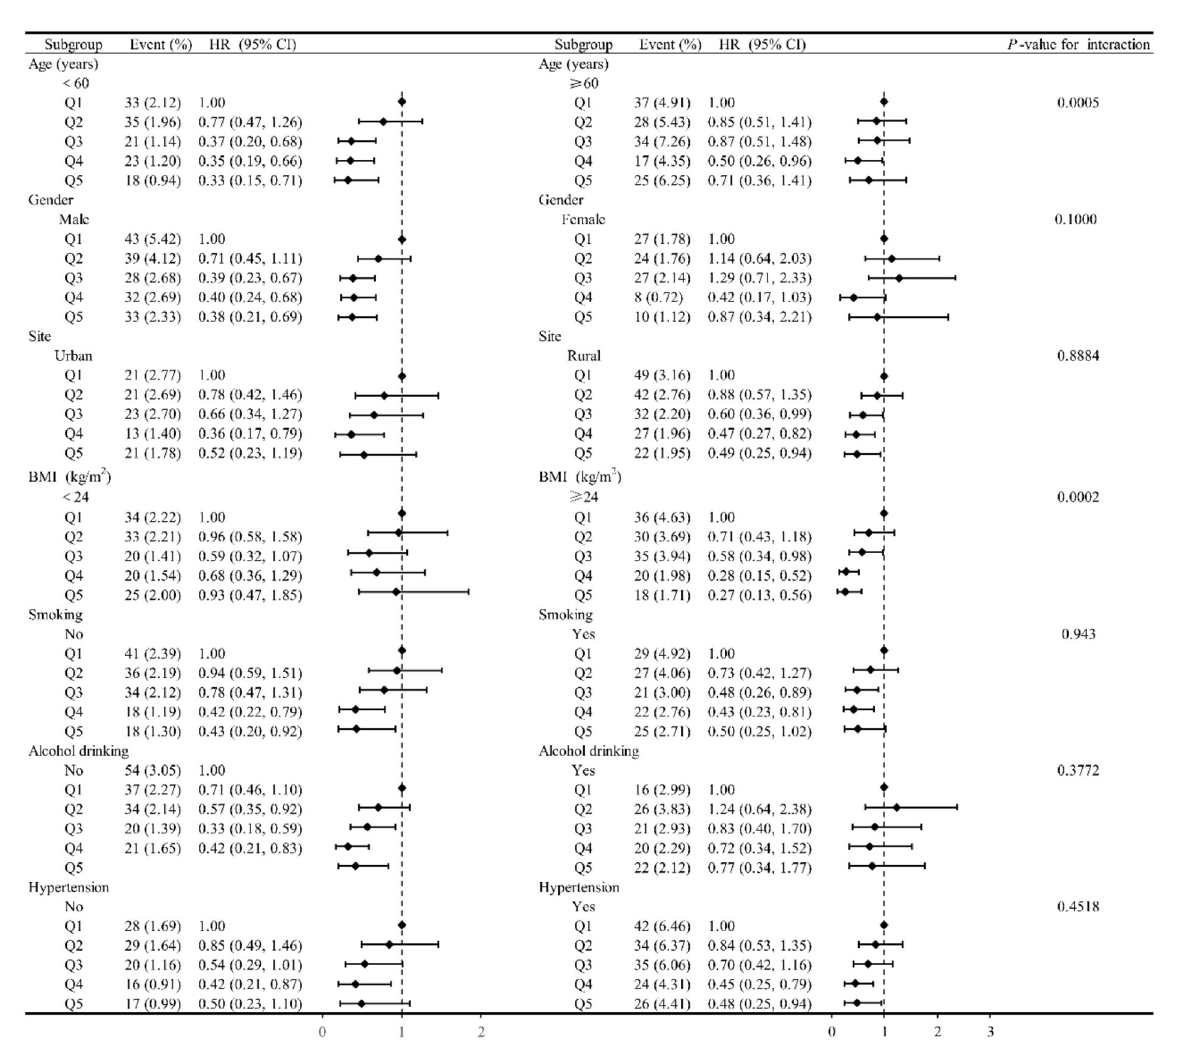
FIGURE3 The relationship between dietary selenium intake and risk of developing stroke according to basic features. Except for the stratification component itself, each stratification factor was adjusted for all other variables (age, gender, race, energy intake, site, marital status, education level, activity level, smoking status, drinking status, BMI, hypertensions, myocardial infarction, diabetes, dietary fiber, niacin, vitamin C, vitamin E, calcium, iron, zinc, magnesium, copper, and manganese).